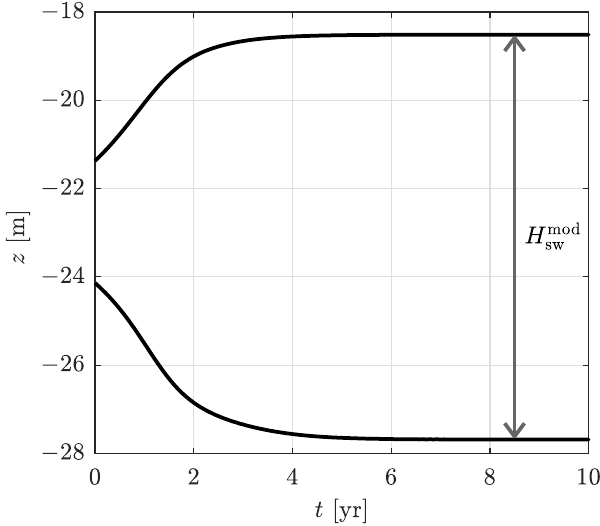
Figure 3. The sand wave crest and through elevation as function of time in the nonlinear model. The sand wave height H mod sw is determined as the difference between crest and trough elevation after the model reached equilibrium. The example run shown here corresponds to validation location number 1 (Table 3).